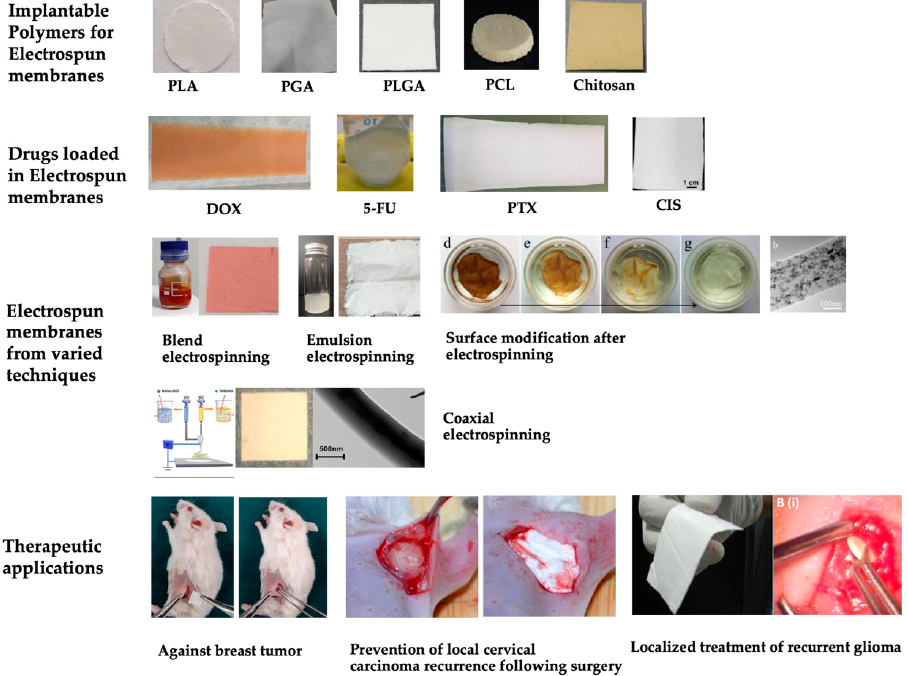
Figure 3. Examples of electrospun membranes fabricated with varied implantable polymeric materials